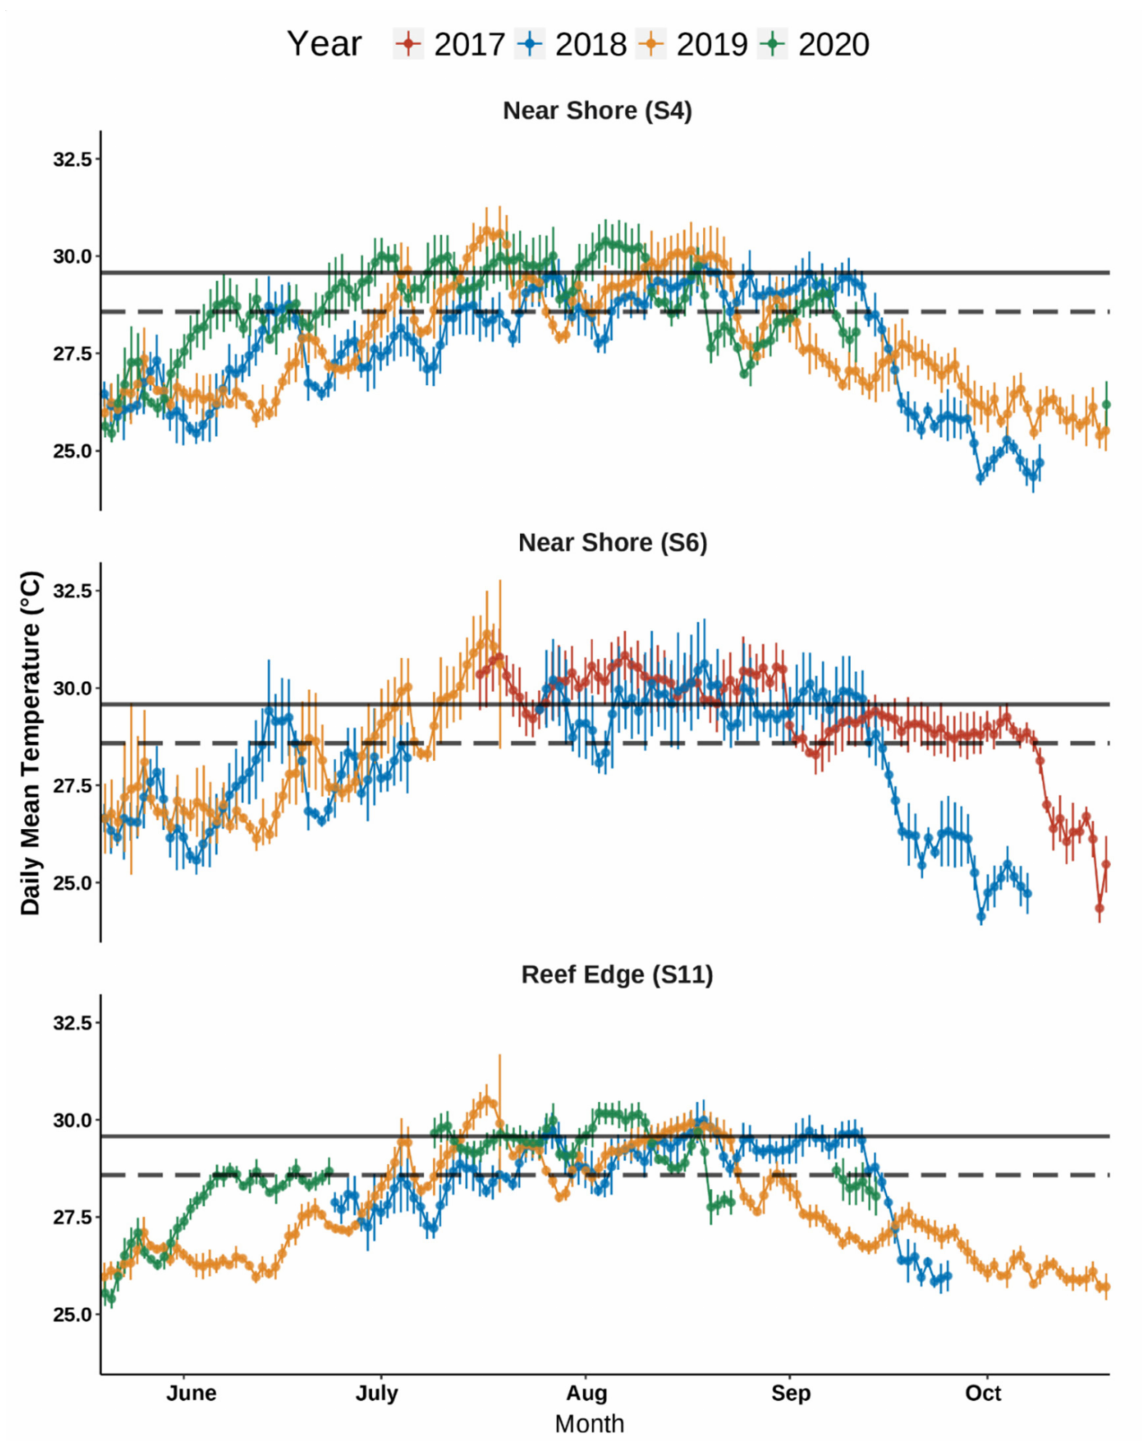
Figure 3. Daily means with +/ − SD (Standard deviation) for NS (S4, S6) and RE (S11) sites. The dashed black line represents the Maximum Monthly Mean (MMM), which is 28.5 ◦ C for the northern Ryukyu Islands [65]. The solid black line is the bleaching threshold, which is usually 1 ◦ C higher than the MMM [64], here set as 29.57 ◦